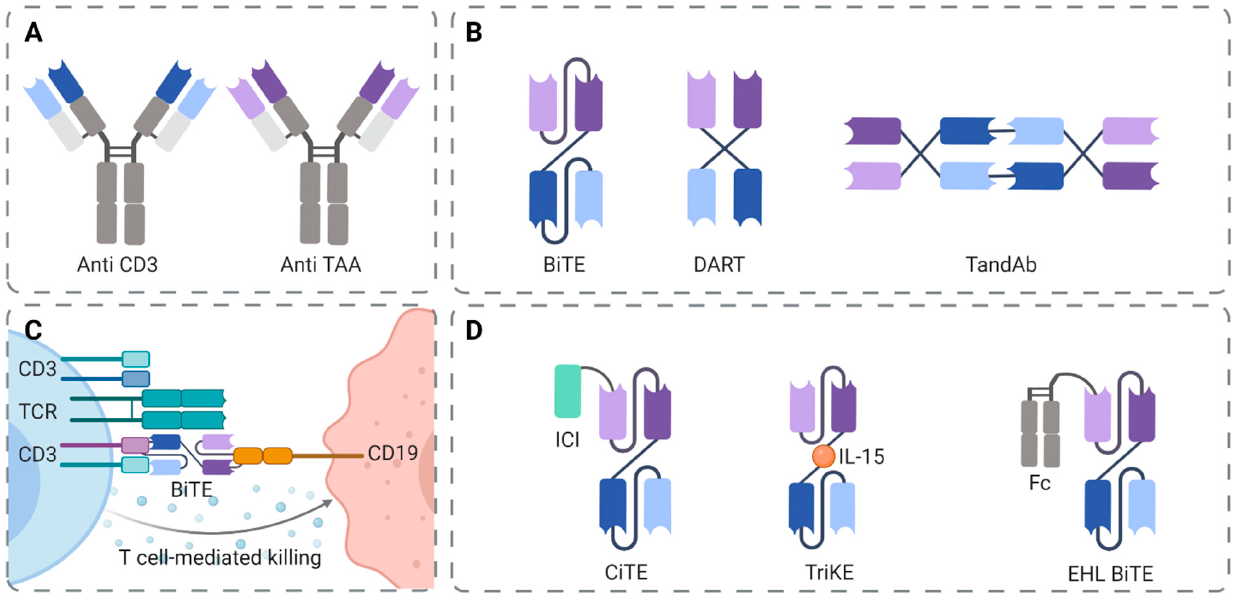
Figure 2. Structure and function of BiTEs: ( A ) Structure of antibodies from which scFv-based BiTEs are derived. ( B ) Structures of bispecific T cell recruiting antibodies. ( C ) MHC-independent targeting of TAAs through the use of BiTE to activate T cells. Example of Blinatumomab is given targeting CD3 and CD19. ( D ) Structural adaptations made to BiTEs to circumvent immune evasion and to optimize stability and half-life. TAA: tumor-associated antigen; BiTE: bispecific T cell engager; DART: dual affinity retargeting antibodies; TandAB: Tandem diabodies; TCR: T cell receptor; ICI: immune checkpoint inhibitor; CiTE: Checkpoint inhibitor T cell engager; TriKE: Tri-specific killer engager; EHL: extended half-life.